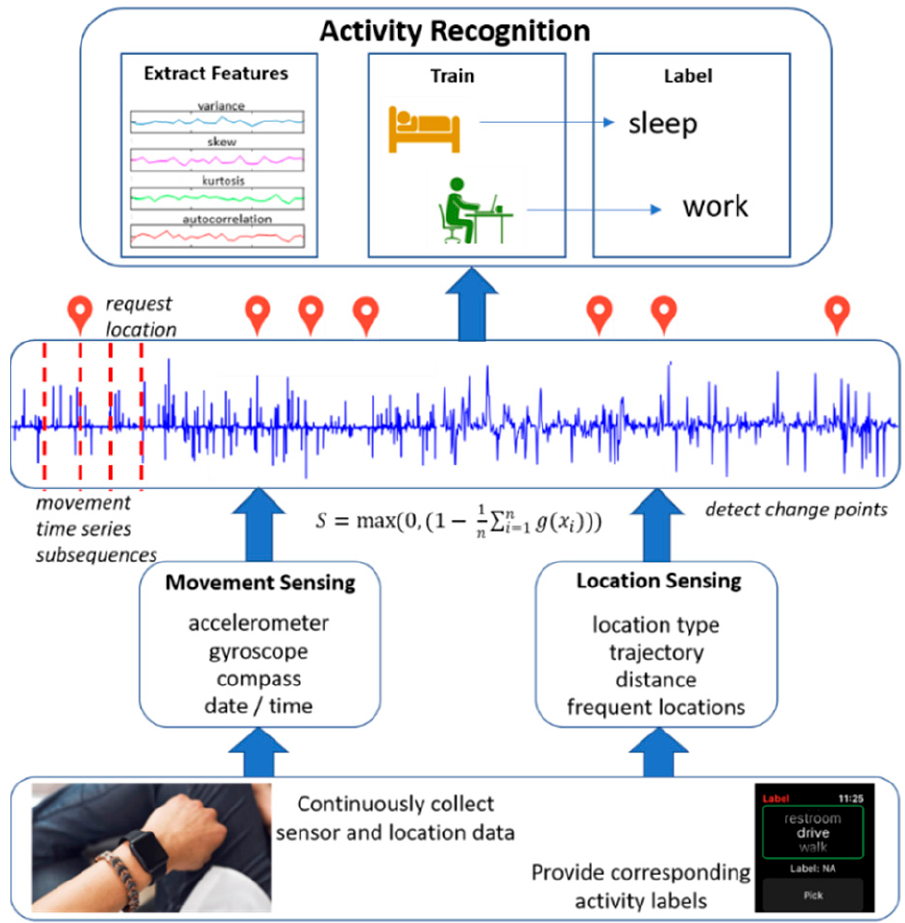
Figure 1. Overview of the Change Point-based Activity Monitoring (CPAM) energy-conserving activity recognition algorithm. Data are continuously collected and are either labeled by users in real time to train the model or labeled by the model once it is trained. Movement and location data are analyzed to find change points and sampling rates are adjusted accordingly. The resulting data are fed to a supervised learner to build activity models.